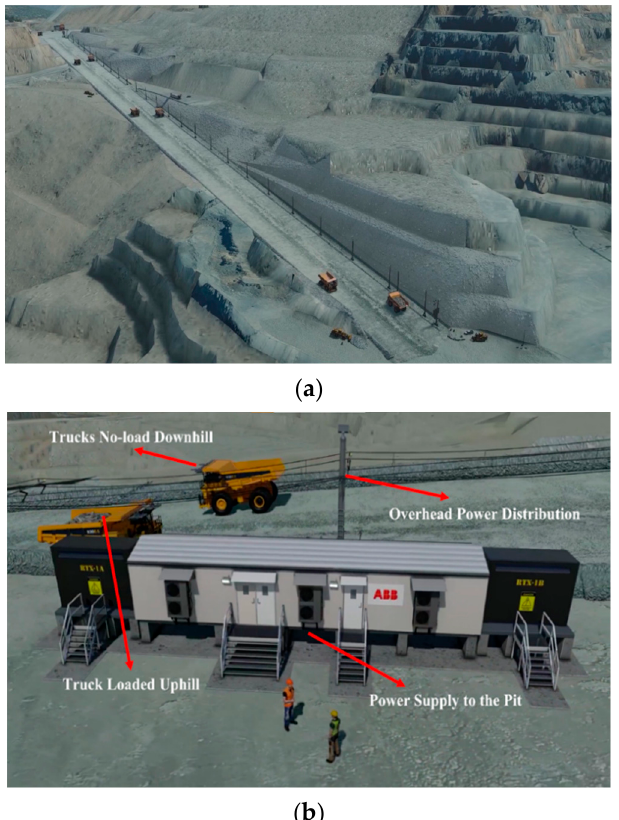
Figure 9. ( a )The overall view of Trolley Assist system (source: ABB). ( b ) The detail of Trolley Assist on the ramp.